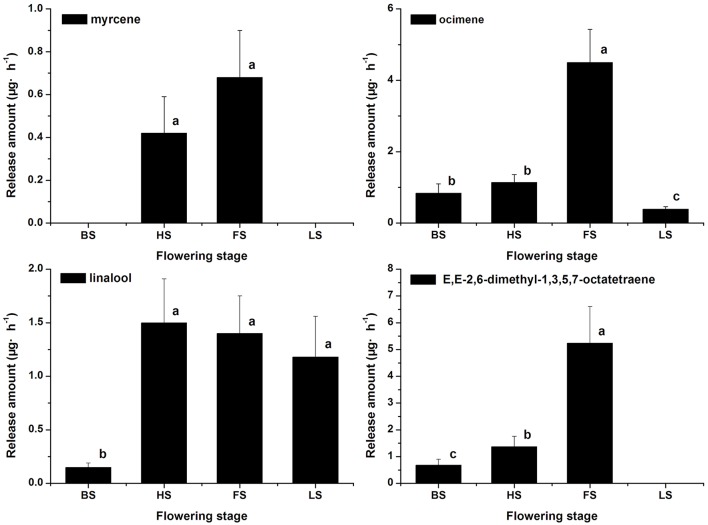
The amounts of terpenoid components emitted from Lilium ‘Novano’. Each bar is the average of three independent biological replications, and standard errors are shown. Statistical significance [least significant difference (LSD)] of the difference in the amounts of floral scent released is indicated by different small letters (P < 0.05).